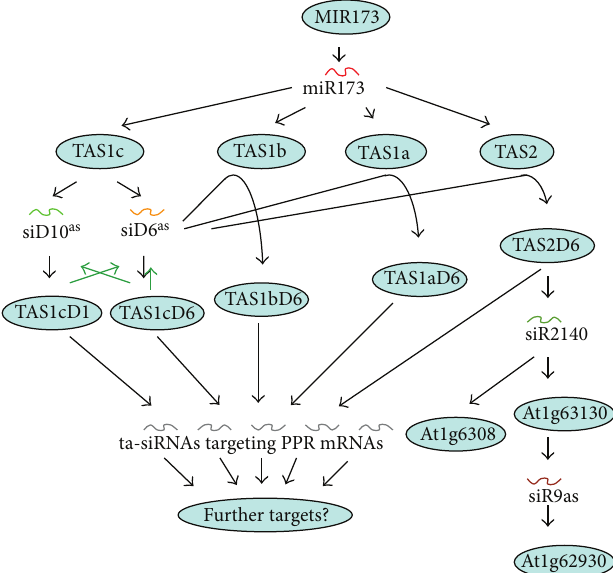
F 10: Cascades initiated by miR173 interaction with TAS1 RNAs. Cartouches show precursor RNAs, which give rise to ta-siRNAs and pha-siRNAs that attack further precursor RNAs leading to cascades of gene